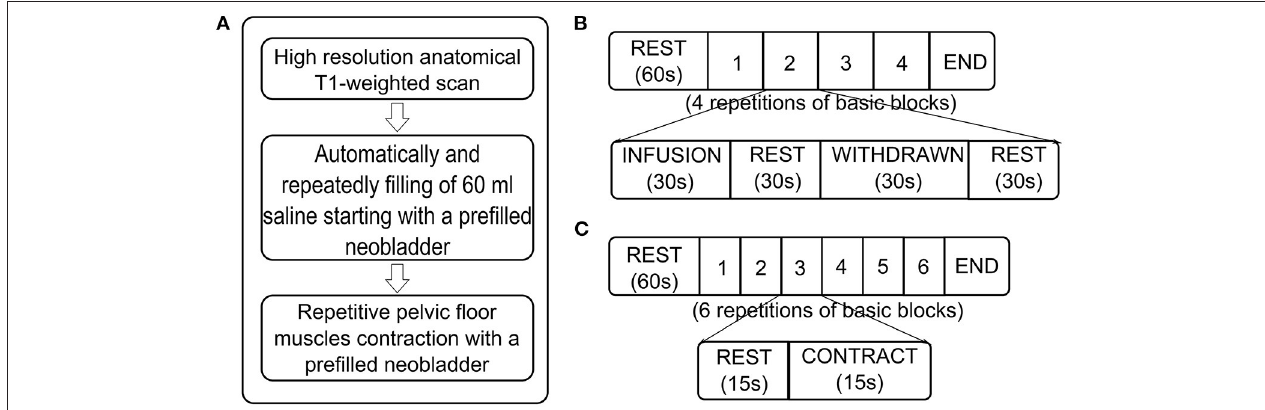
FIGURE 1 | Flow diagram of MRI measurements. (A) Sequences of MRI scans. (B) Scan paradigm of task-related functional MRI (fMRI) about neobladder volume sensation. Starting with a “baseline” rest (60s, no specific stimulus or task was performed), it consisted of four repetitive blocks, each with four conditions: (1) automated infusion of 60ml of body warm saline into the neobladder; (2) rest; (3) withdrawal of 60ml of saline from the neobladder; and (4) rest. (C) Scan paradigm of task-related fMRI about continence. It started with a “baseline” rest (60s, no specific stimulus or task is performed) and consisted of six repetitive blocks, each with two conditions: (1) rest and (2) pelvic floor muscle